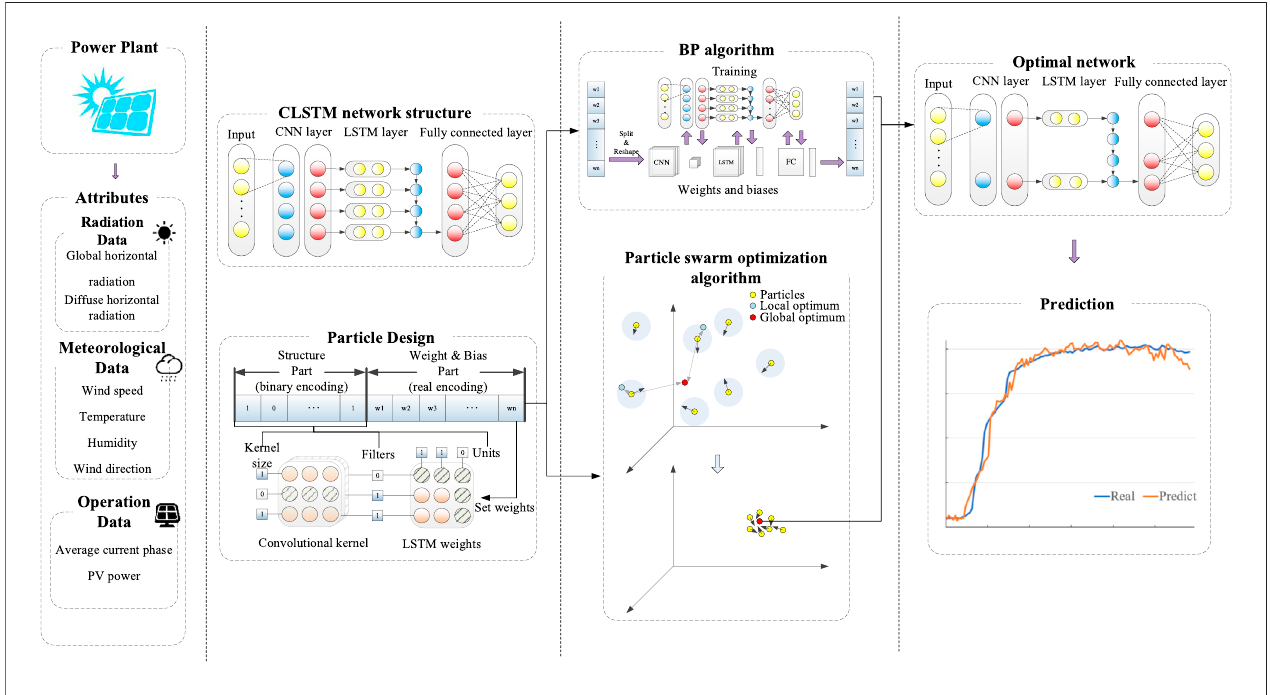
FIGURE 2 | Framework of the AMPSO-CLSTM prediction